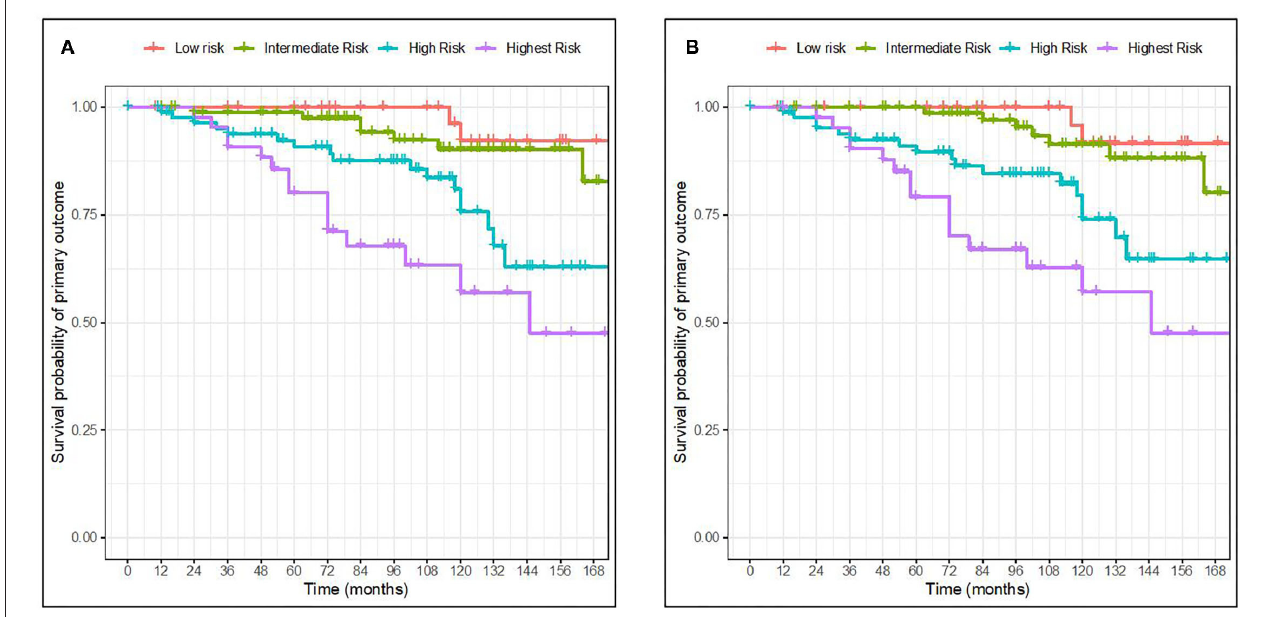
FIGURE 2 | Kaplan-Meier curves for survival probability of primary outcome in 4 risk groups based on the percentile of the linear predictor. Full model with race (A) . Full model without race (B) . The 4 risk groups were defined as < 16th (low risk), ∼ 16th to < 50th (intermediate risk), ∼ 50th to < 84th (higher risk), and > 84th (the highest risk) percentiles of the linear predictor from the full model without and with race, respectively.